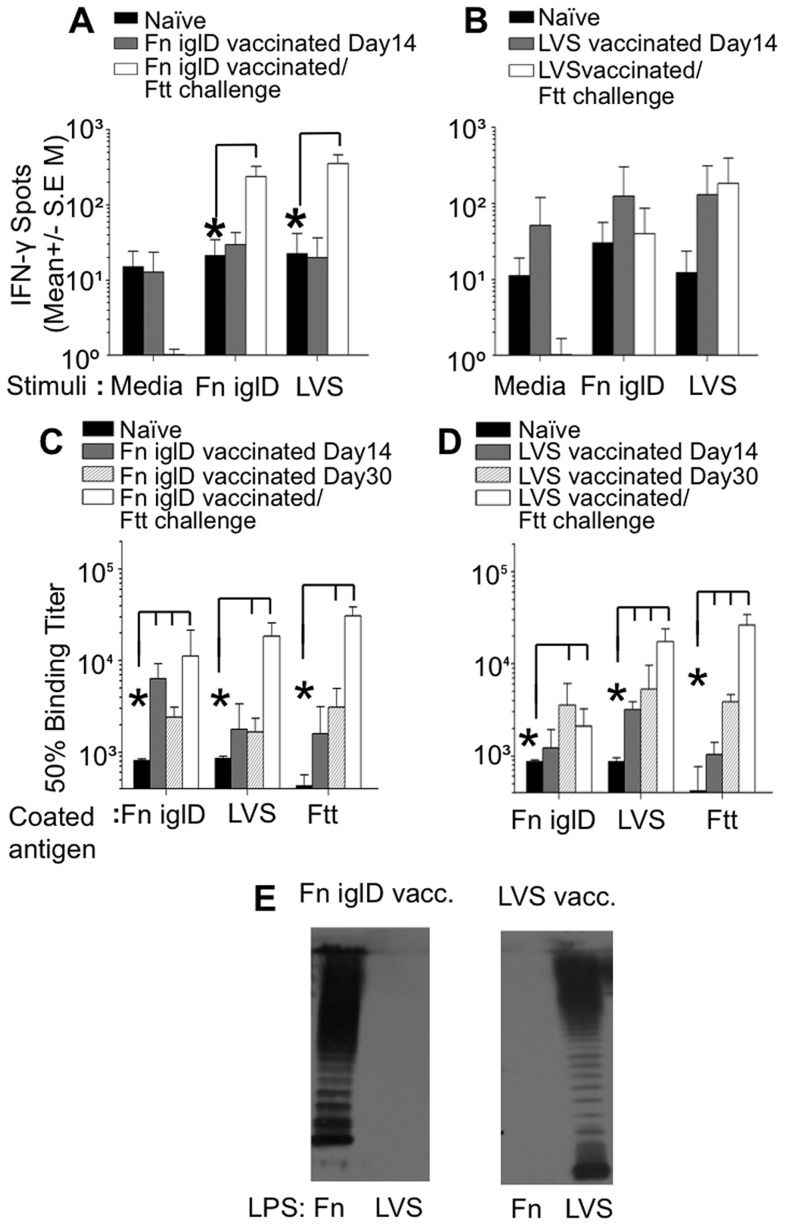
Cellular and humoral responses to Francisella spp. in vaccinated NHP.PBMCs were prepared from (A) Fn iglD- and (B) LVS-vaccinated NHPs either prior to vaccination (naïve), on day 14 post-vaccination, or 30 days post Ftt pulmonary challenge. 200,000 cells/well were stimulated ex vivo with UV-inactivated Fn-iglD (2×106 CFU/ml equivalent) or formalin-fixed LVS (1×105 CFU/ml equivalent) or left unstimulated (medium). IFNγ production was measured by ELISPOT. Assays were performed in triplicate. * indicate significantly (p<0.05; Student t test) more cells produced IFN-γ at the time point indicated as compared to levels measured from naive NHP (Day 0) using the same stimuli. Sera from Fn iglD- (C) and LVS-vaccinated (D) NHPs were analyzed pre-vaccination (naïve), on days 14 and 30 post-vaccination, and 30 days post-Ftt pulmonary challenge by ELISA for total Ab against whole cell killed Fn iglD, LVS, and Ftt antigen. Responses of individual Fn iglD-vaccinated NHPs are shown in Fig. S7 * indicate significantly (p<0.05; Student t test) higher Ab at the time point indicated as compared to levels measured from naive NHP (Day 0) using the same stimuli. (E) Sera from a Fn iglD- (left) and LVS-vaccinated NHP (right) were analyzed on day 30 post-vaccination for reactivity to Fn LPS and LVS LPS by Western immunoblot. Sera were from AO8245 (Fn iglD-vaccinated) and AO8090 (LVS-vaccinated), and equivalent amounts of LPS were loaded in each well.